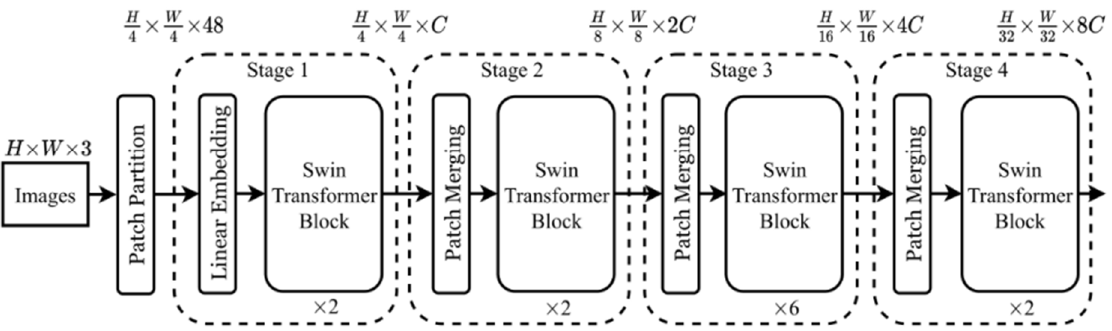
Figure 4. The overall structure of the Swin